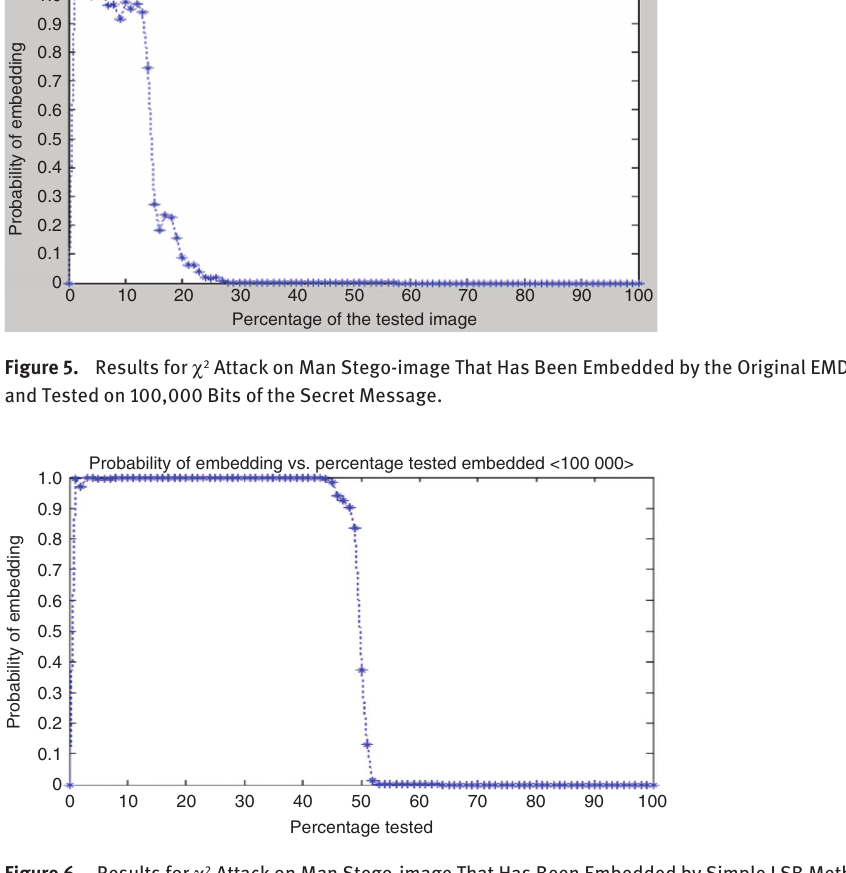
Figure 6. Results for χ 2 Attack on Man Stego-image That Has Been Embedded by Simple LSB Method and Tested on 100,000 Bits of the Secret Message.